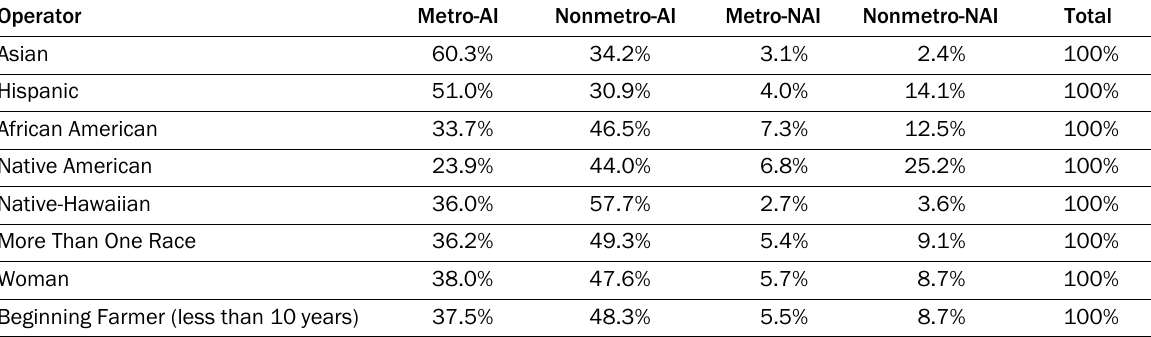
Table 12. Farmer Demographics by County Type, 2007